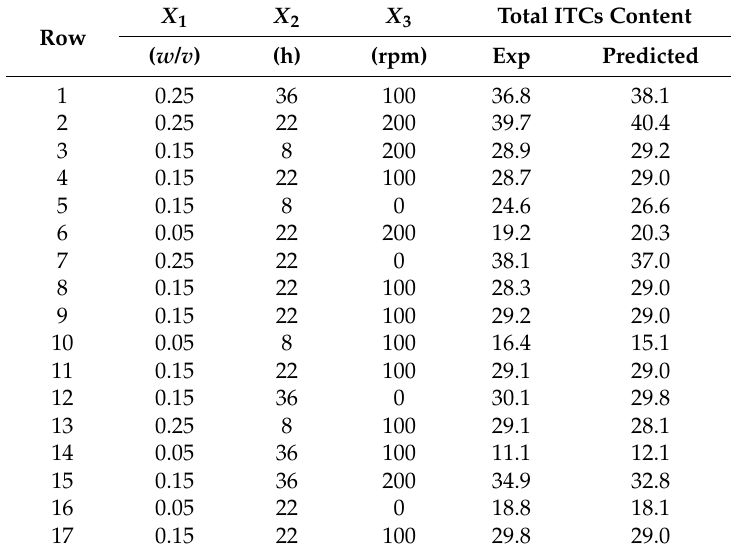
Table 4. Box-Behnken experimental design for the three independent variables (S/L ratio, fermentation time and agitation rate), experimental and predicted values for isothiocyanates (ITCs) content.